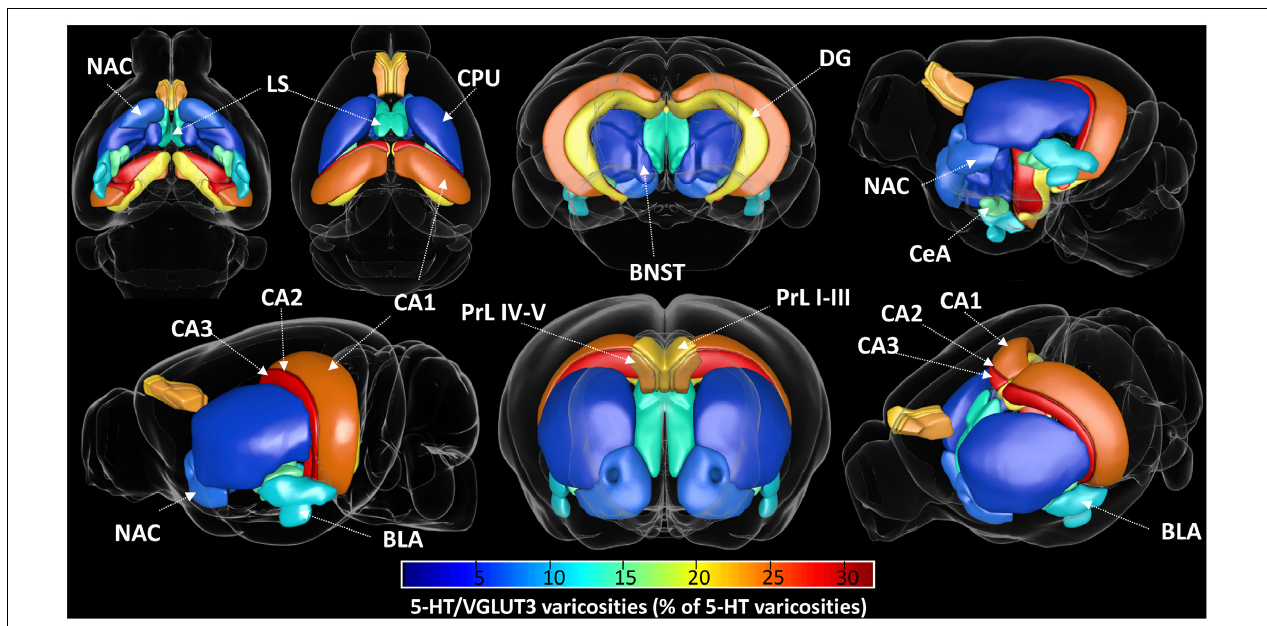
FIGURE 9 | Visual representation of the proportion of 5-HT varicosities expressing the vesicular glutamate transporter VGLUT3 in various regions of the mouse forebrain. The percentage of total 5-HT varicosities that are co-labeled with VGLUT3 is represented with a color coding from 0 (dark blue) to 32% (dark red) within each analyzed brain region, from various viewing angle. The highest proportion of VGLUT3 was found in CA2, followed by CA3, CA1, PrL IV-V, PrL I-III, DG, CeA, BLA, NAc shell, BNST, and NAc